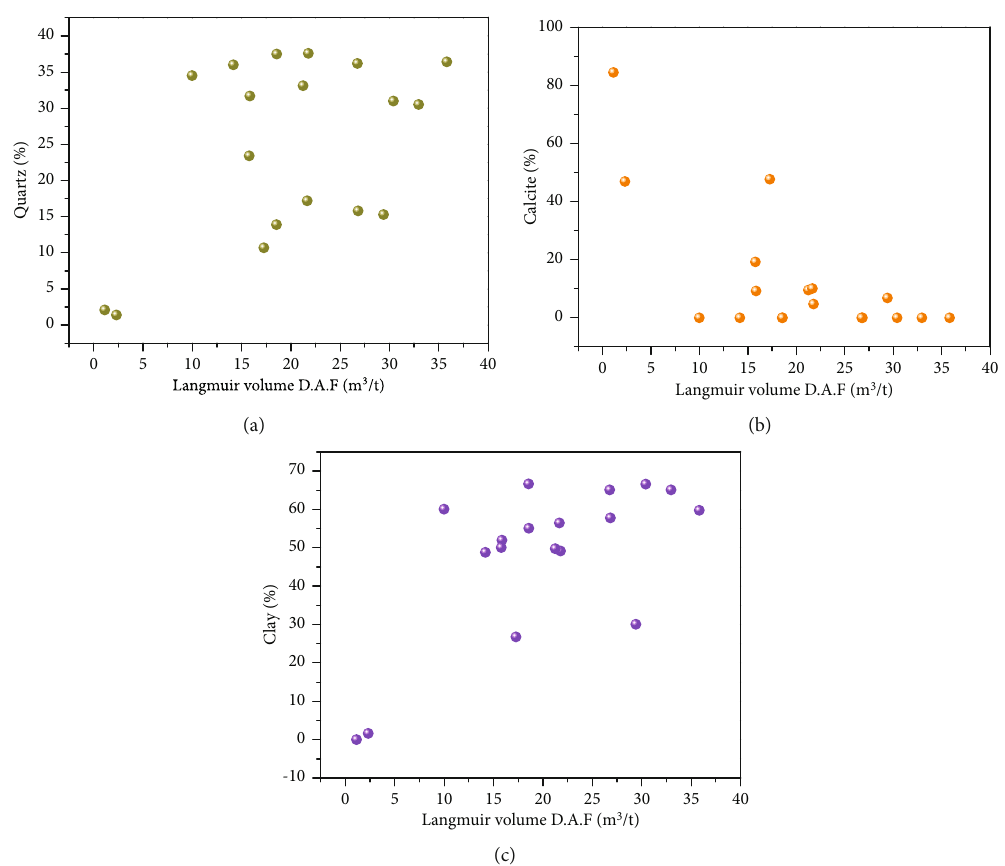
Figure 12: (a) Shows the plot correlation between Langmuir volume of dry ash-free samples versus quartz. (b) Shows the plot correlation between Langmuir volume of dry ash-free samples versus calcite. (c) Shows the plot correlation between Langmuir volume of dry ash-free samples versus clay minerals. Table 4: Distribution of InterP porosity, IntraP porosity, and total porosity of the SF and TF in the Ordos